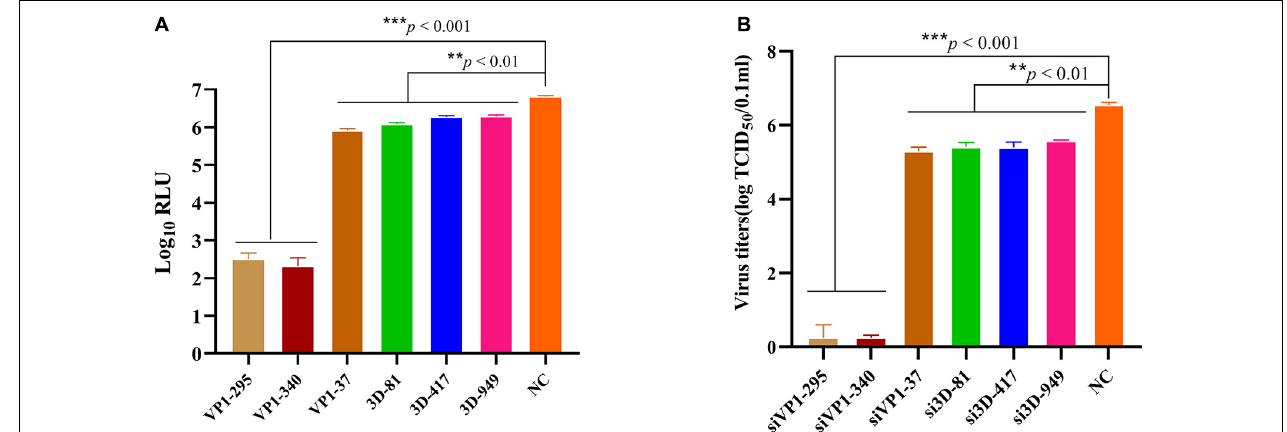
FIGURE 6 | Antiviral siRNAs screening using rSVA-Nluc. (A) Screening of antiviral siRNAs using rSVA-Nluc. BHK-21 cells were transfected with six siRNAs followed by infection with rSVA-Nluc at an MOI of 0.1 for 48 h and assayed for Nluc activity. (B) Viral titers of rSVA-Nluc in siRNA-treated cells. BHK-21 cells were transfected with six siRNAs followed by infection with rSVA-Nluc at an MOI of 0.1 for 48 h. TCID 50 values are the means of three repeat titrations at the time points indicated. Data represent three independent experiments and are shown as mean ± standard deviation, and p -values of paired Student’s t -test are shown (NS, not significant;